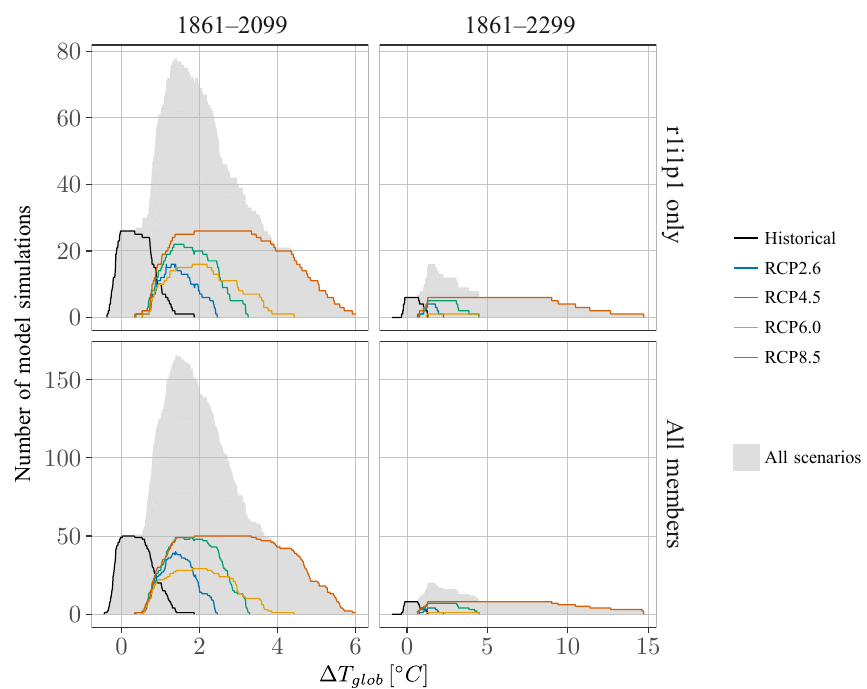
Figure A8. Number of models simulating a specific global mean temperature ( x axis) per scenario (coloured lines) and for all scenarios combined (grey shading), subdivided by the time period covered (columns) and by the number of ensemble members used (rows). The number of data points shown in each subplot is the same for each region and index except from (cid:49)P − E , where we do not use simulations from CMCC-CMS, as evaporation is not available from this model (see Table